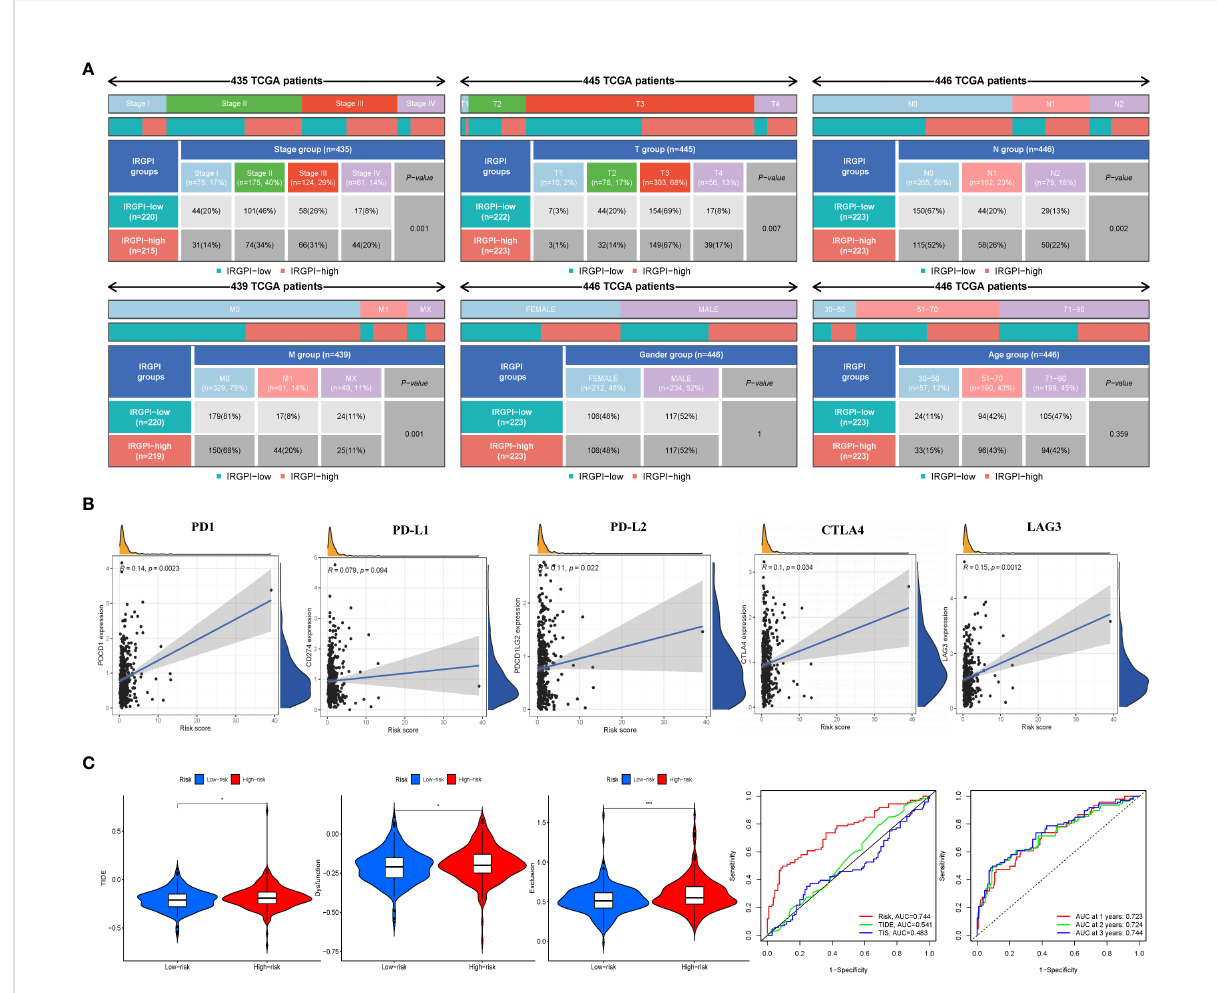
FIGURE 4 IRGPI signifcantly correlates with clinicopathological factors in CRC patients and the analysis of immunotherapy responses. (A) Heatmap and table showing the distribution of multiple clinicopathological factors in CRC patients between two IRGPI subgroups. (B) Scatter plots coordinated by IRGPI risk score with immune checkpoint PD-1, PD-L1, PD-L2, CTLA4, and LAG3, respectively. (C) TIDE, dysfunction, and T-cell exclusion score in different IRGPI subgroups. The scores between the two IRGPI subgroups were compared through the Wilcoxon test (* p < 0.05, *** p < 0.001). (D) Performance comparison between IRGPI risk, TIDE, and TIS in predicting 1-year OS in the TCGA cohort. Time- dependent ROC curve and AUC values in the TCGA